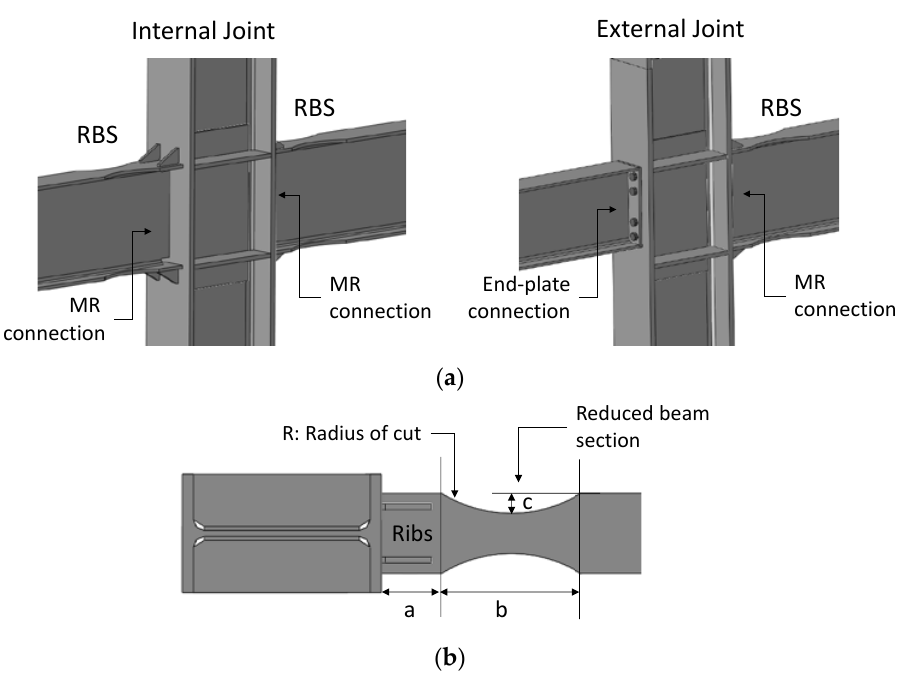
Figure 2. Moment-resisting (MR) and end-plate connection of both internal and external joints ( a ) and main geometrical features of the RBS connection ( b ). Table 2. Features of the designed